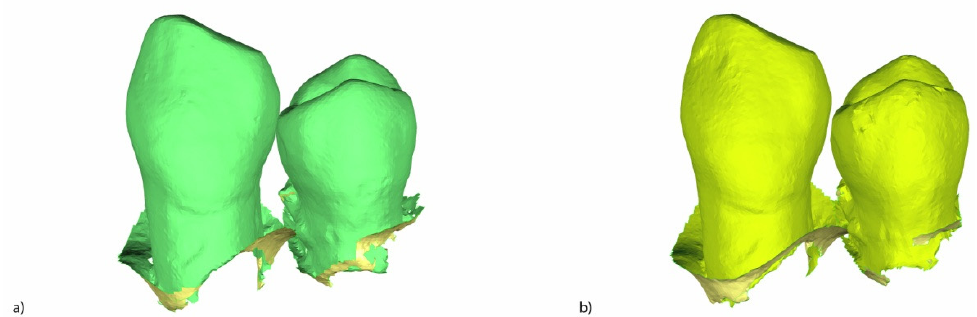
Figure 3. ( a ) Buccal view of the individually segmented tooth, 3.3 and 3.4 of the preoperative and ( b ) postoperative interproximal enamel reduction STL digital files.